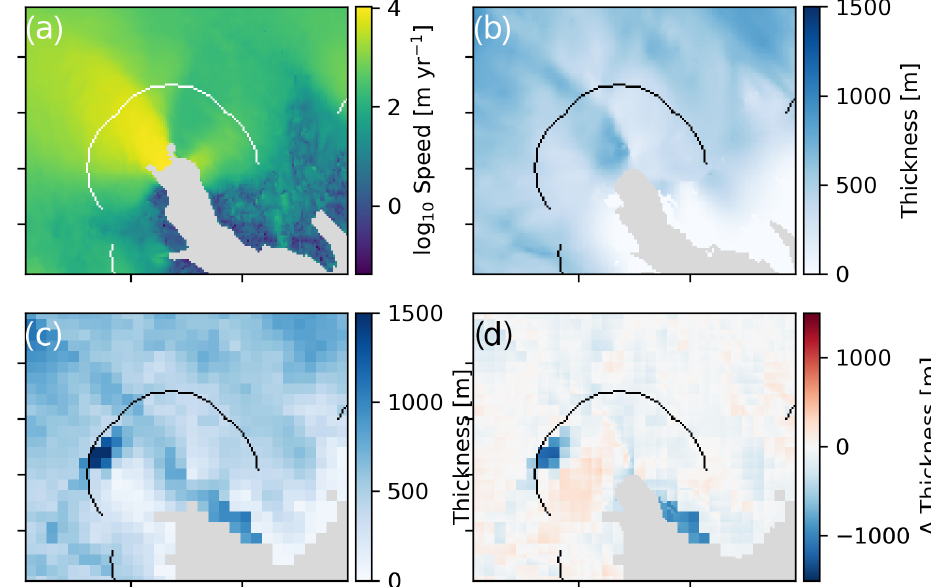
Figure B1. Differences between BedMachine (Morlighem et al., 2017b) and Bamber et al. (2013) near Køge Bugt. (a) is baseline ice speed, (b) BedMachine thickness, (c) Bamber et al. (2013) thickness, and (d) the difference computed as BedMachine − Bamber. The curved line is the gate used in this